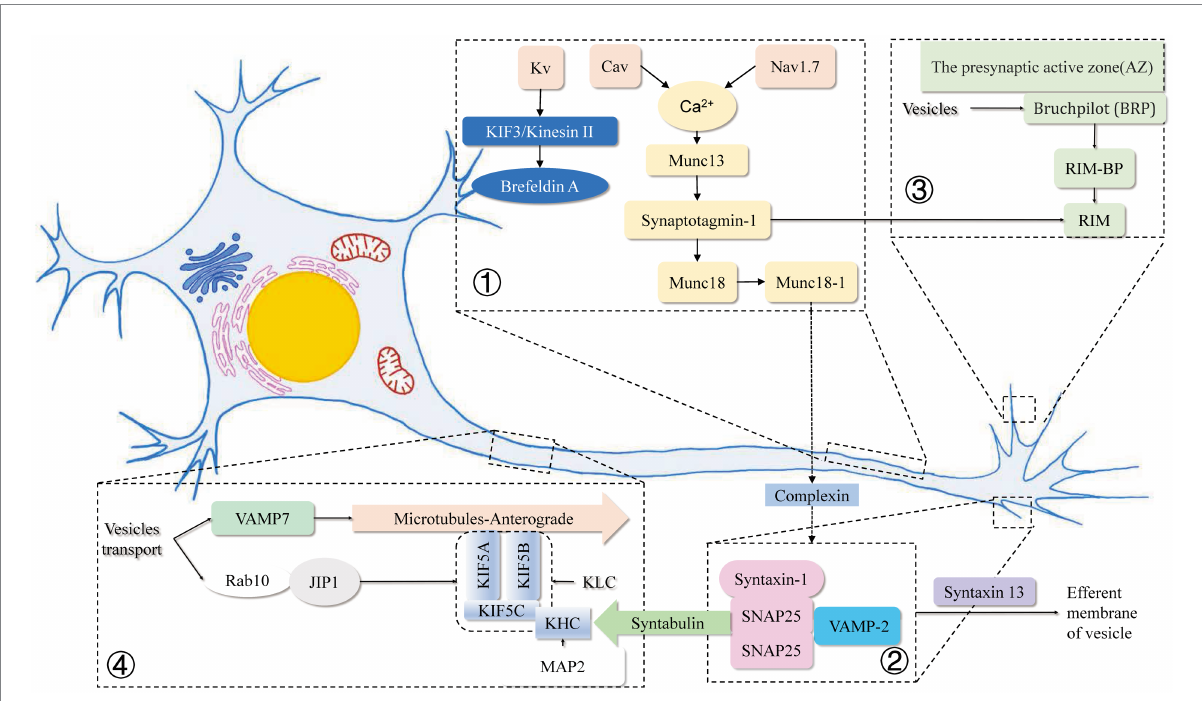
FIGURE 1 Mechanisms related to intracellular vesicle movement and endocytosis and exocytosis within axons in this review. ① Voltage-gated sodium (Nav) channels accumulate at high concentrations in the axonal initial segment (AIS), and the membrane-inserted Nav1.7 at the axon terminal reduces retrograde transport and vesicle surface stability. Elevation of basal Ca 2+ in the presynaptic terminal increases presynaptic Ca 2+ and vesicular glutamate release due to the reverse operation of the plasma membrane Na + /Ca 2+ exchanger (NCX). Cav binds to the SNARE complex to remove the complexed protein from the SNARE complex in a Ca 2+ dependent manner. Kvb2 is responsible for the targeted delivery of Kv1 channel proteins to Brefeldin A-containing vesicles at the ends of axonal microtubules through microtubule (MT) plus end-tracking protein (+TIP) EB1 and KIF3/ kinesin II. ② SNAREs have been recognized as key components of protein complexes that drive membrane fusion. Munc18-1 and Munc13 are involved in the regulation of the SNARE complex, and the linker region between the SNARE motifs depends on the closed conformation formed by the binding of syntaxin 1 and Munc18-1. The synergistic mechanism of Munc18-1 releasing and SNAP25/synaptobrevin binding to synapxin 1 may lead to more efficient core complex formation in vivo . Syntabulin was identified as the receptor for the traditional kinesin I heavy chain, which is specific for syntaxin-containing cargo vesicles through a direct interaction between syntabin and syntabulin. ③ Direct binding of SNAP-25 to the kinesin heavy chain has an indispensable role in exocytosis and axonal outgrowth. RIM and Munc proteins assist in the release of neurotransmitters from vesicles. ④ Rab10 is localized on the vesicle membrane and, by binding to JIP1, is co-encapsulated by two specific KHC subunits of KIF5A and a heterotetramer composed of two kinesin light chain (KLC) subunits. MAP2 strongly impairs the motor activity of KIF5 by inhibiting KIF5 binding to the microtubule track. Spastin KO increases the retrograde velocity of vesicles in axons by interacting with